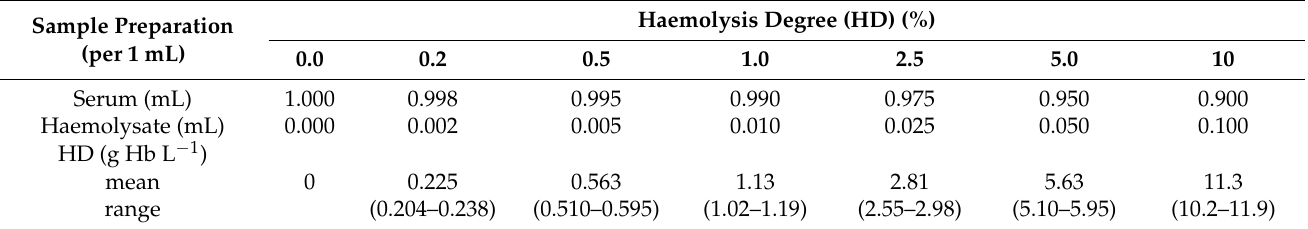
Table 1. Sample preparation for determination of the haemolysis degree in